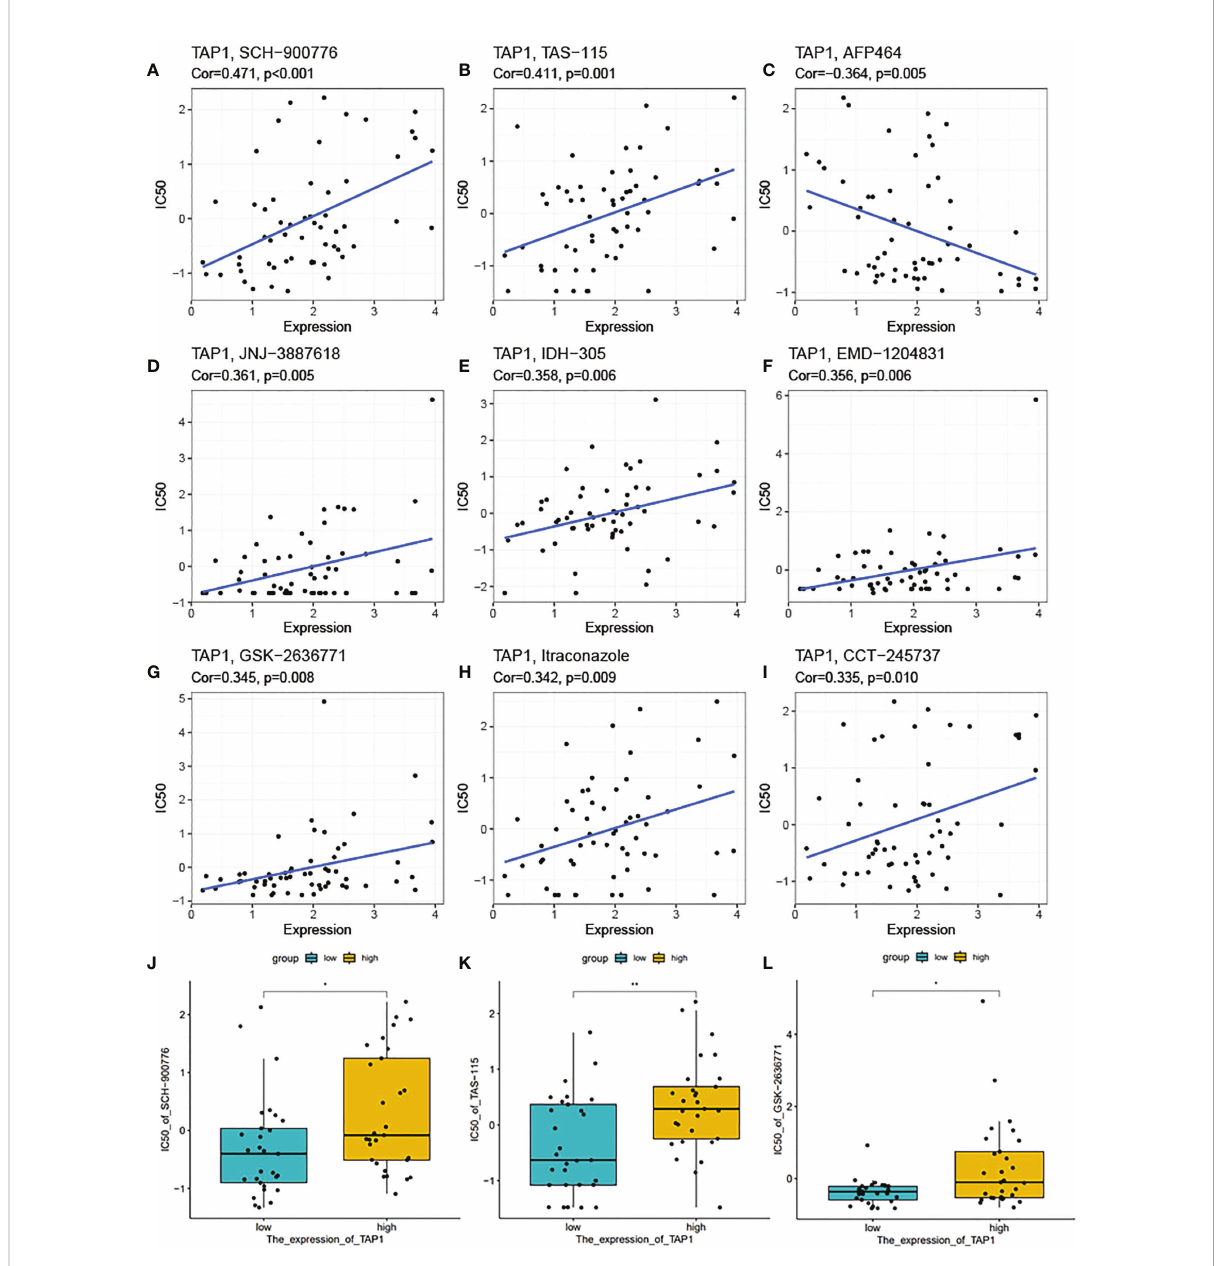
FIGURE 8 TAP1 impacted potential effect of chemotherapy drugs. (A-I) Correlation of TAP1 expression and half maximal inhibitory concentration (IC50) of different drugs obtained from the CellMiner database, including SCH-900776 ( A, Cor=0.471, p<0.001), TAS-115 ( B , Cor=0.411, p=0.001), AFP464 ( C , Cor=-0.364, p=0.005), JNJ-3887618 ( D , Cor=0.361, p=0.005), IDH-305 ( E , Cor=0.358, p=0.006), EMD-1204831 ( F , Cor=0.356, p=0.006), GSK-2636771 (G, Cor=0.345, p=0.008), Itraconzole ( H , Cor=0.342, p=0.009), CCT-245737 ( I , Cor=0.335, p=0.010). (J-L) Different IC50 of medicines based on the expression of TAP1 downloaded from the Cancer Cell Line Encyclopedia (CCLE) database ( J , SCH-900776, K , TAS-115, L , GSK-2636771). *, P < 0.05; **, P <